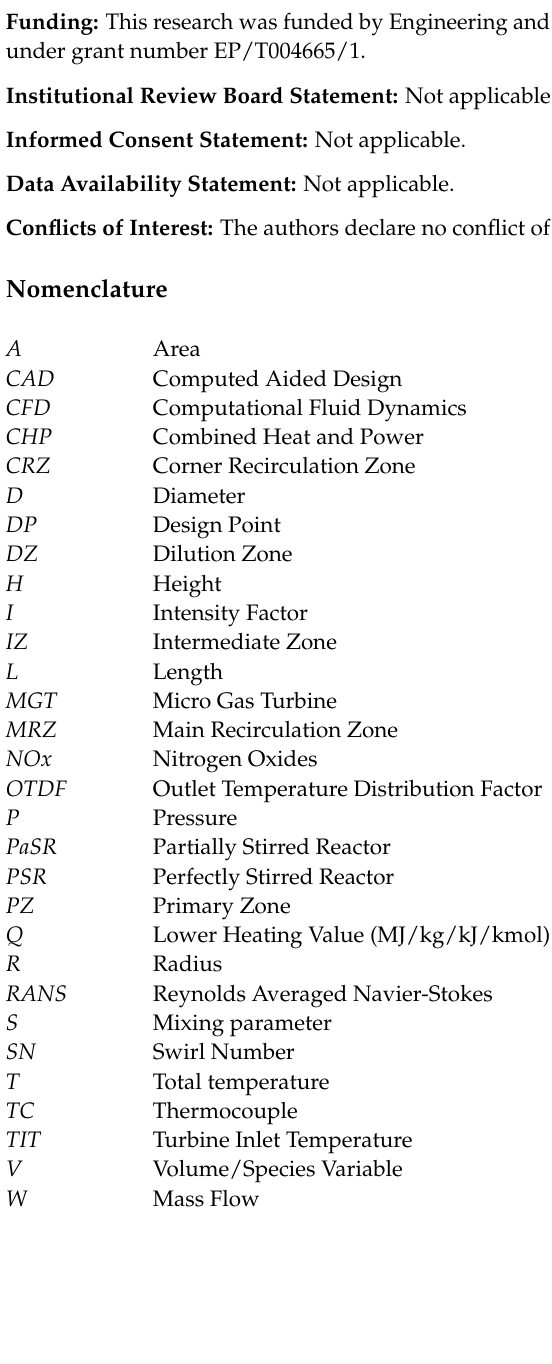
Figure 21. Combustion stabilisation